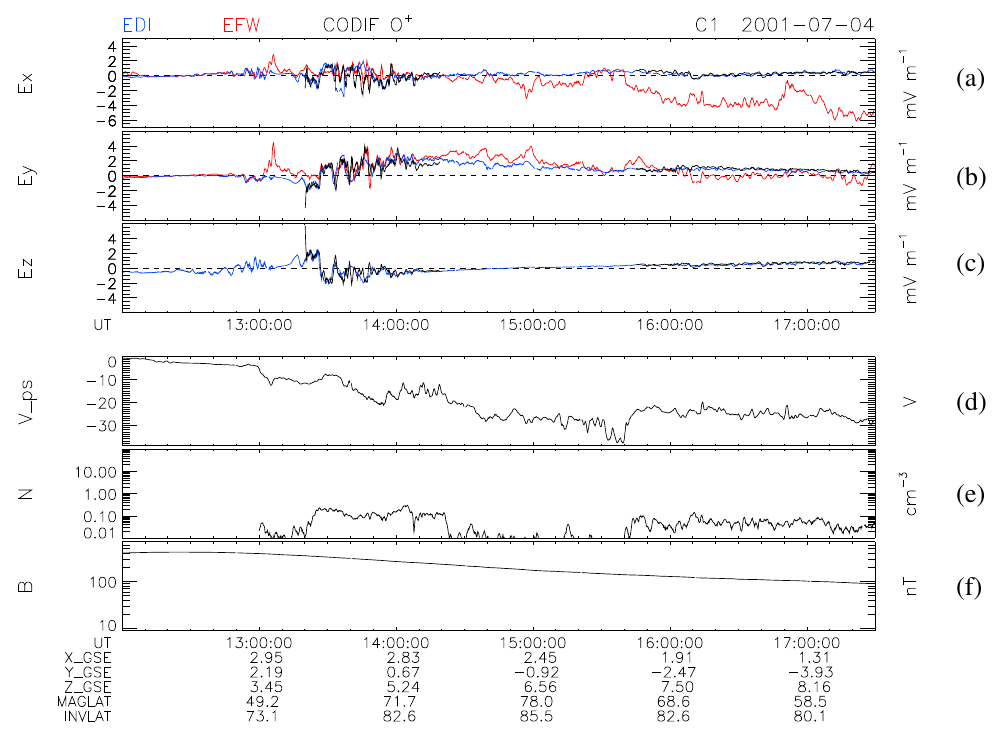
Fig. 6. Comparison of EFW and EDI data from the plasmasphere through the cusp/cleft into the polar cap. Format as in Figure 4.